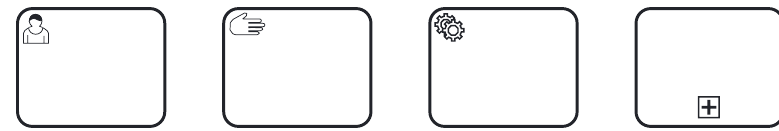
Figure 1. BPMN shapes for task objects